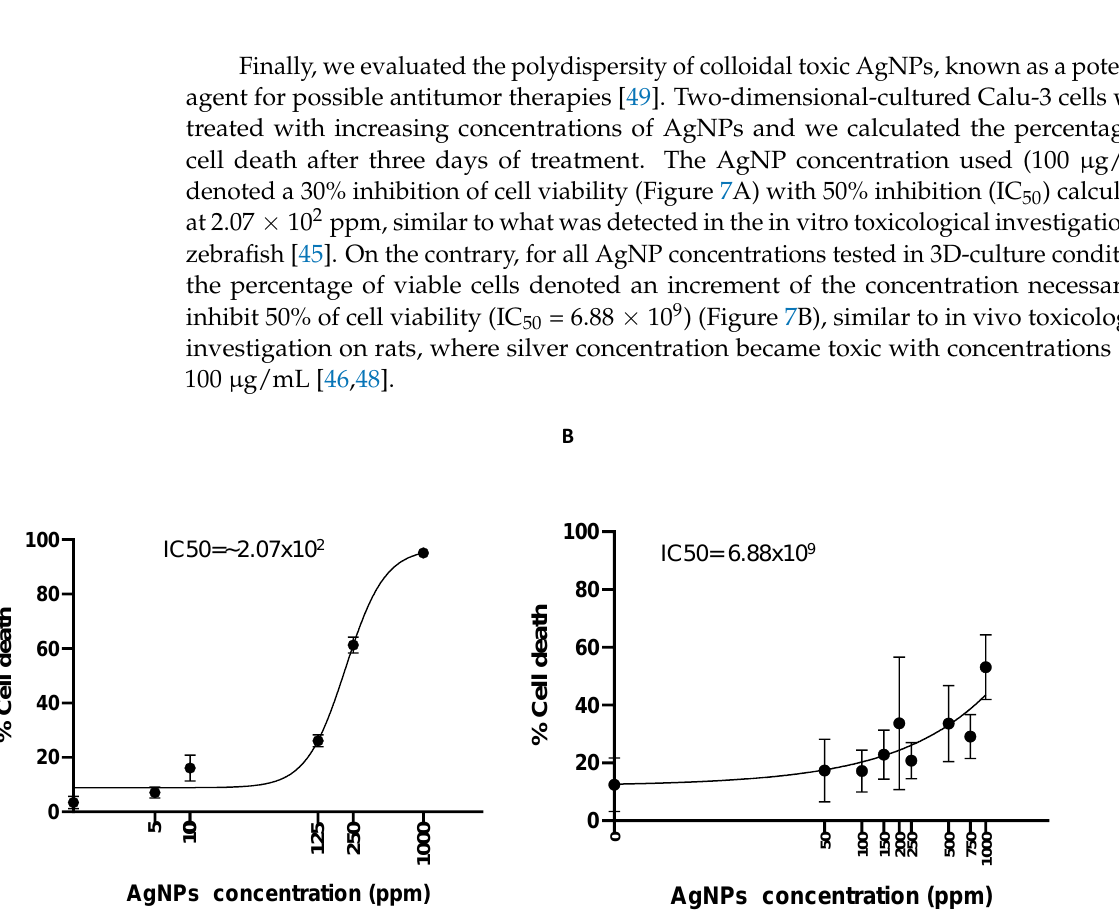
Figure 7. Nanotoxicity exerted by silver nanoparticles in 3D-printed cell-laden multilayer. ( A ) Dose/response for Calu-3 exposed to Ag NPs (from 0 to 1000 ppm) in 2D environment for 48 h. ( B ) Same as ( A ) for the 3D-printed